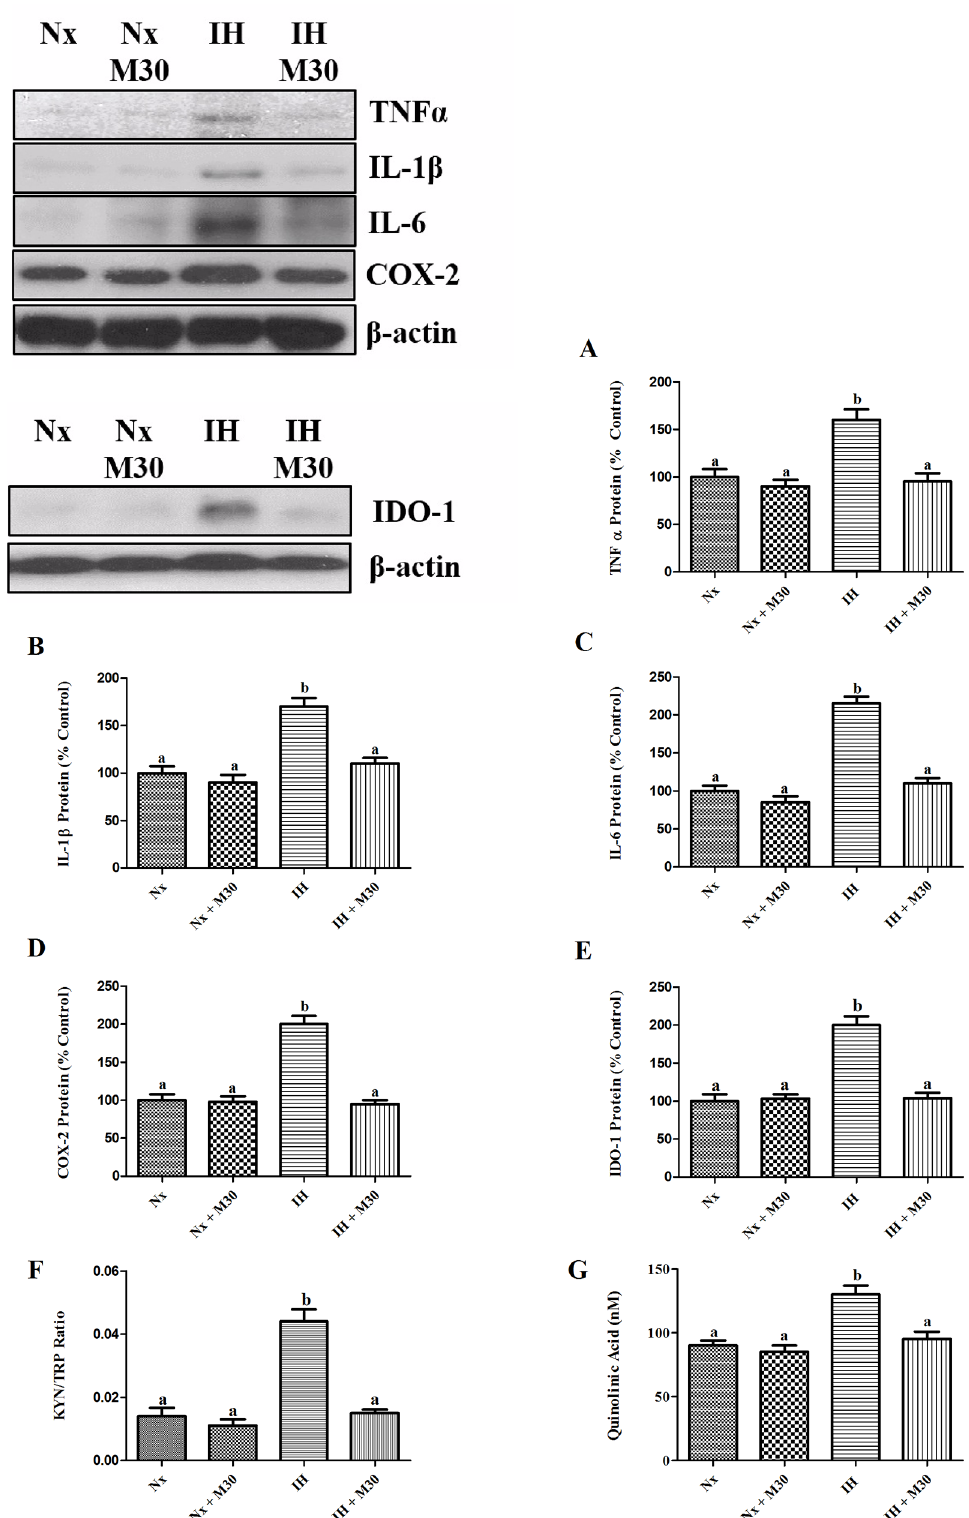
Fig 6. Hypoxia induced inflammation and activated cytokine-responsive IDO-1 in the hippocampus. Levels of the protein expression(A) TNF α , (B) IL-1 β , (C) IL-6, (D) COX-2, (E) IDO-1, (F) the ratio of KYN/TRP